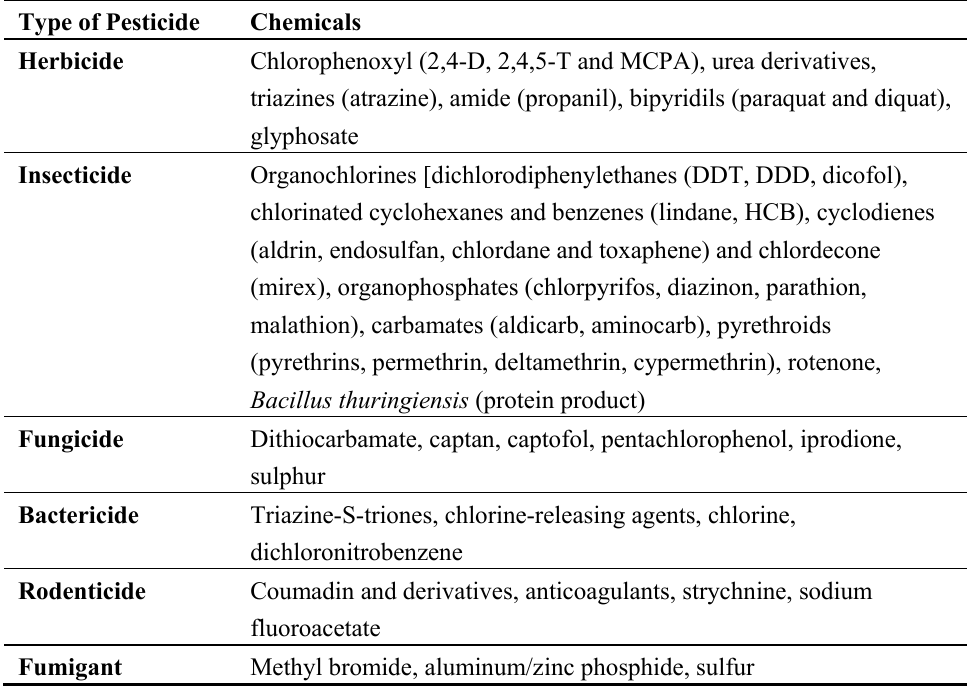
Table 1. Categories of commonly used